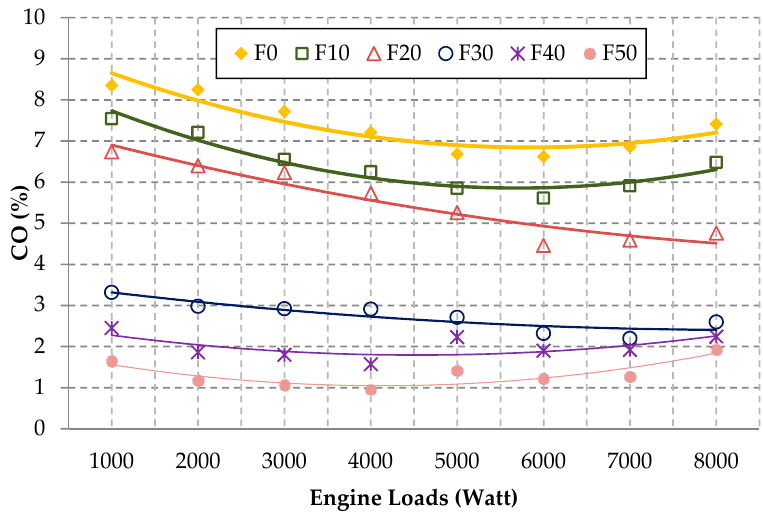
Figure 7. CO emission changes with engine loads.